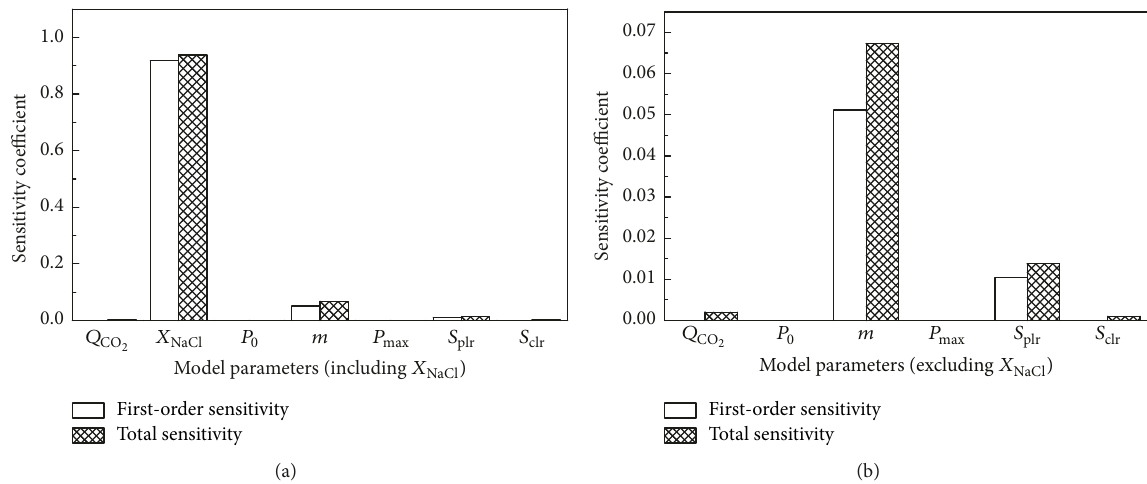
Figure 12: First-order and total sensitivity coefficients of salt precipitate model ((a) contain all the parameters, and (b) removes the most influential parameters ( 𝑋 )). NaCl